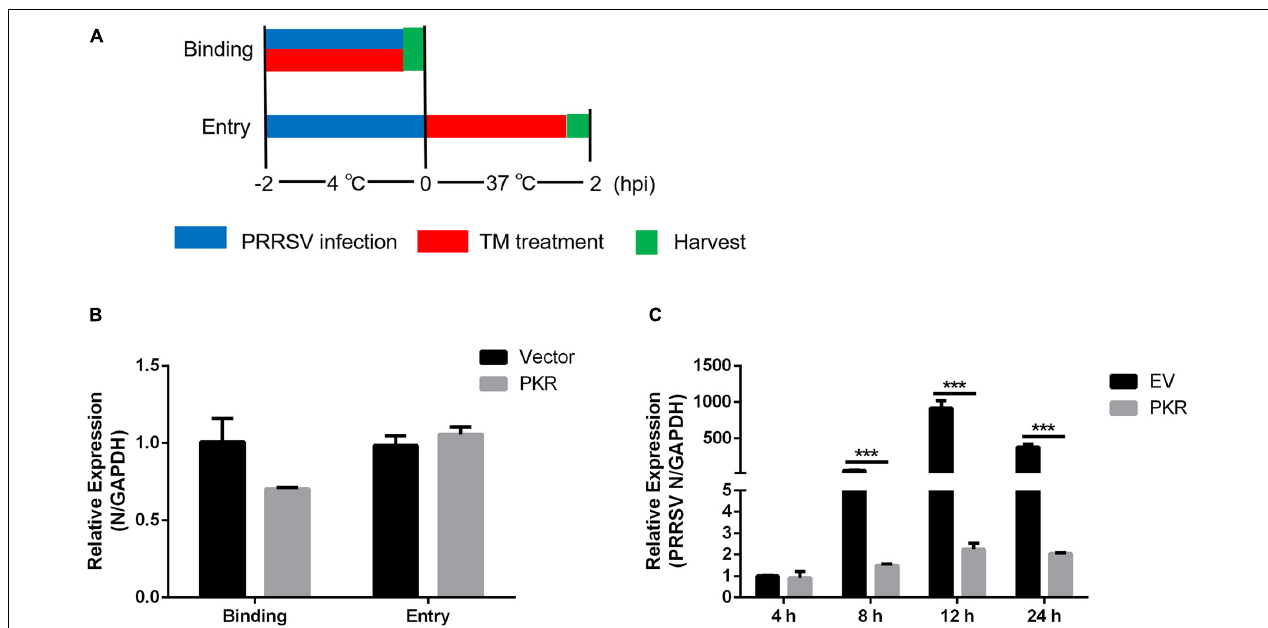
FIGURE 5 | Effects of PKR on virus binding, entry, and replication. (A) Schematic diagram of virus binding and entry assays. (B) Empty vector and Myc-tagged PKR were transfected into Marc-145 cells for 24 h, followed by virus binding and entry assays. qRT-PCR was used to detect PRRSV N levels. GAPDH is shown as an internal control. (C) Empty vector- and PKR-transfected Marc-145 cells were incubated with PRRSV (MOI = 1) for the indicated time (4, 8, 12, and 24 hpi). The mRNA expression of PRRSV N was shown, as measured by qRT-PCR. Data are the results of three independent experiments (means ± SE). Significant differences are denoted by * p < 0.05, ** p < 0.01, and *** p <